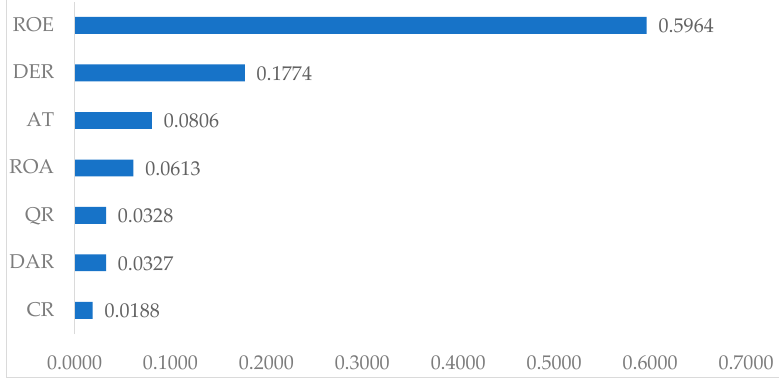
Figure 2. Entropy weights of financial ratios